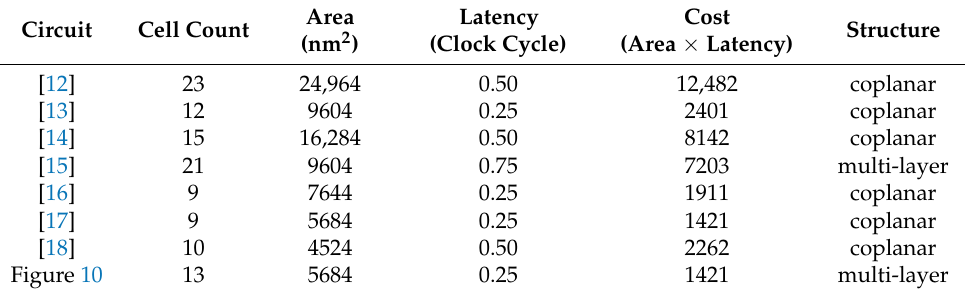
Table 5. Performance comparison of QCA 2-to-1 Mux.